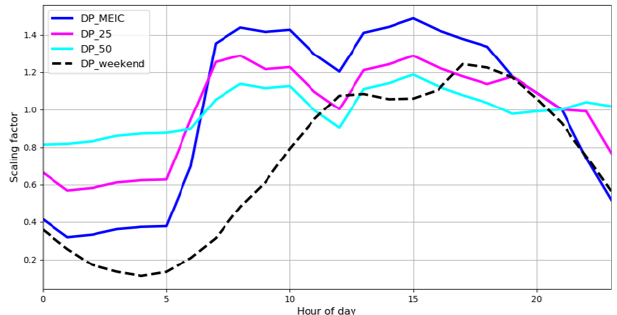
Figure 17. Diurnal emissions profiles applied to the simula- tions shown in Fig. 18. Standard MEIC diurnal emissions pro- file (DP_MEIC) marked by blue line; modified DP_MEIC with increased proportions of nighttime emissions marked by pink (DP_25) and cyan (DP_50) lines and weekend emissions profile marked by dashed black